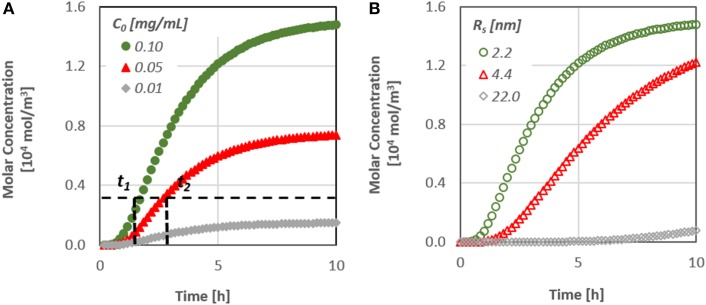
(A) Effect of the initial substance concentration on the diffusion characteristics [t(1, 2) time needed to reach a specified concentration value at the pulp] and (B) Effect of the molecular size on the diffusion characteristics.